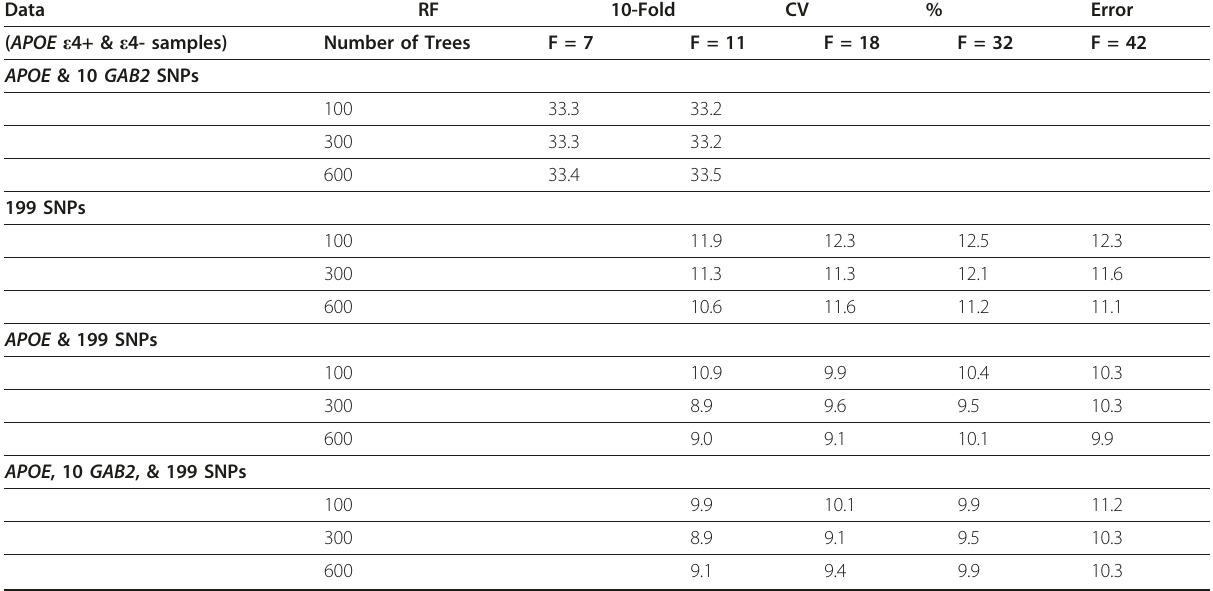
Table 2 RF modeling, filtered data, approach I